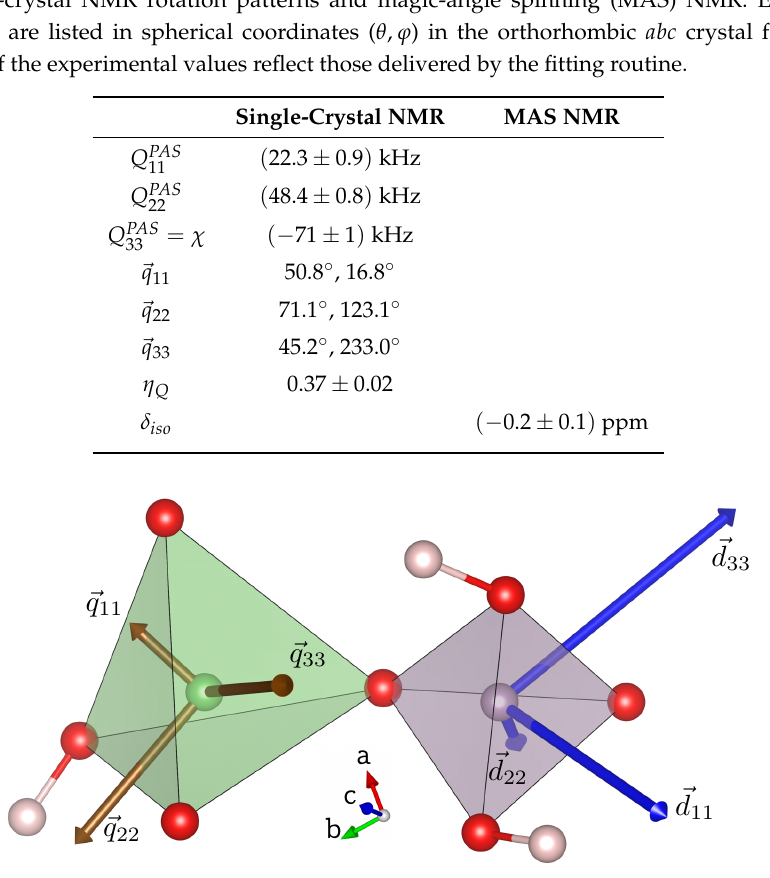
Figure 7. LiO 4 and PO 4 polyhedra with related hydrogen atoms in the LDP crystal structure (colour scheme identical to that in Figure 1b). The bold arrows show the principal axes of the 7 Li Q tensor (brown) and 31 P CS tensor (blue), scaled according to the magnitude of the associated eigenvalues, such that an absolute value of 10 kHz (for 7 Li) and 10 ppm (for 31 P) corresponds to a length of 0.4 Å. (Drawing generated with the V ESTA program